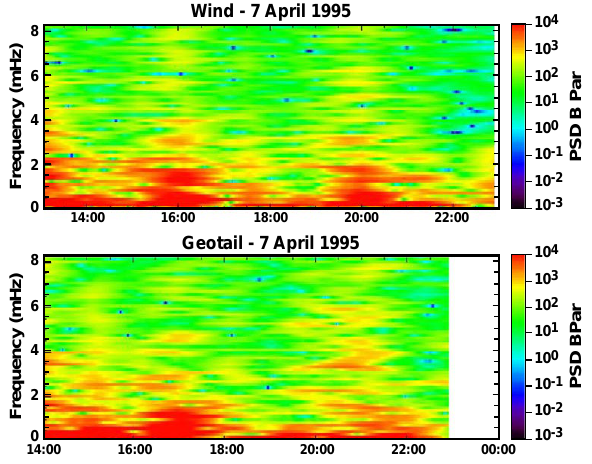
Fig. 7. PSD for Wind (top panel) and Geotail (bottom panel) on 7 April 1995.